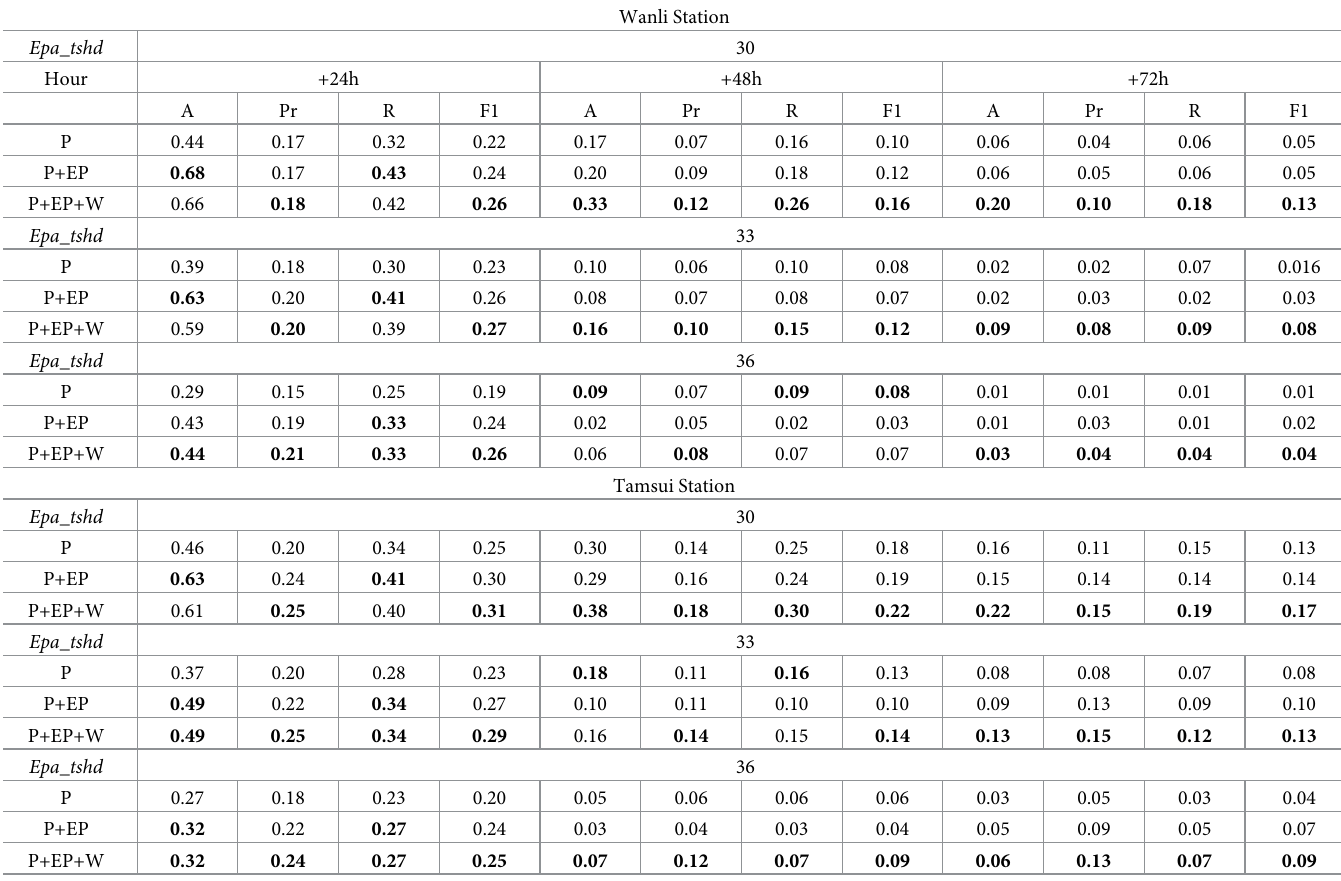
Table 5. Classification results with Diff_tshd = 1.5 .